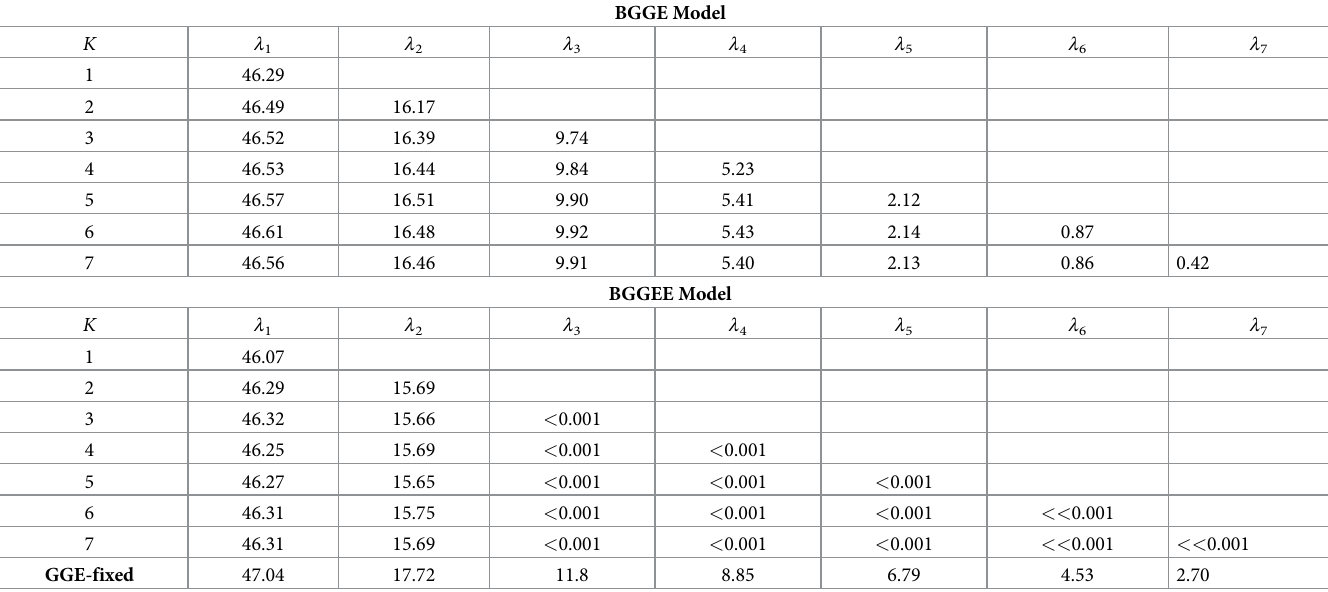
Table 1. The posterior means for singular values for the BGGE and BGGEE models as a function of the number of bilinear terms (k = 1,2, ... ,